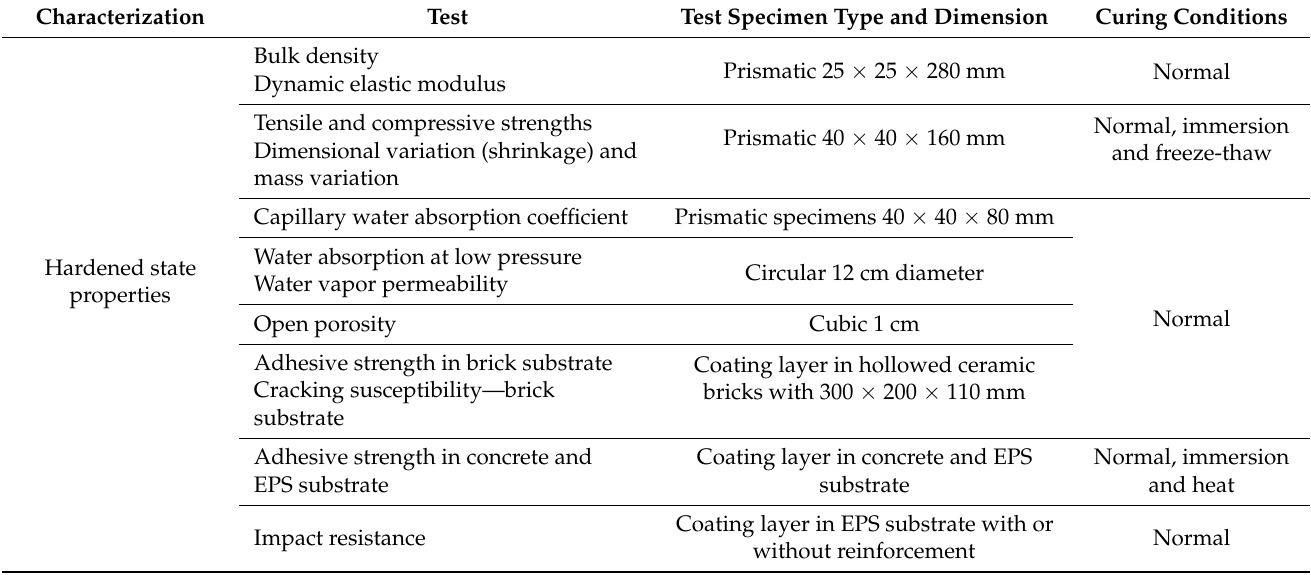
Table 5. Specimens and respective curing conditions for each